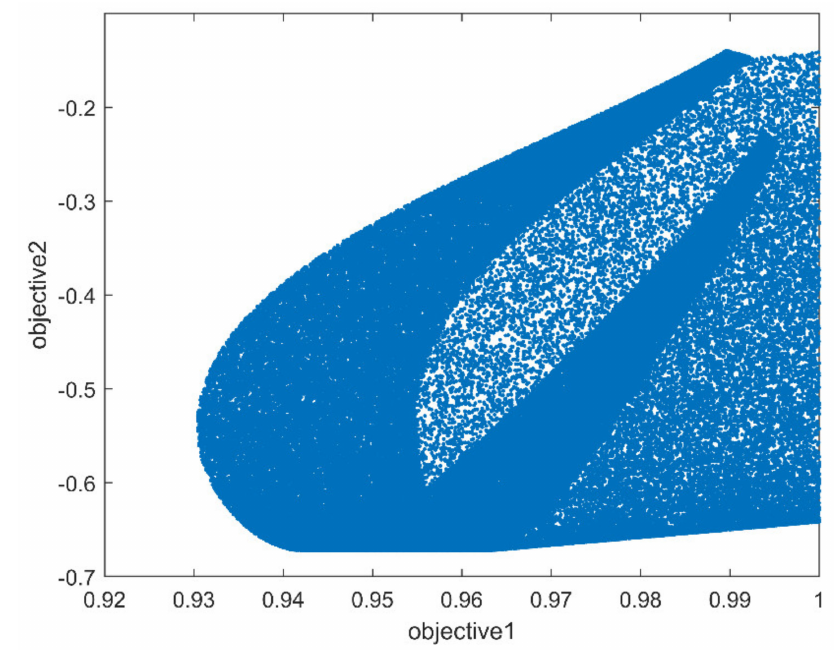
Figure 5. The design feasible space of the optimization